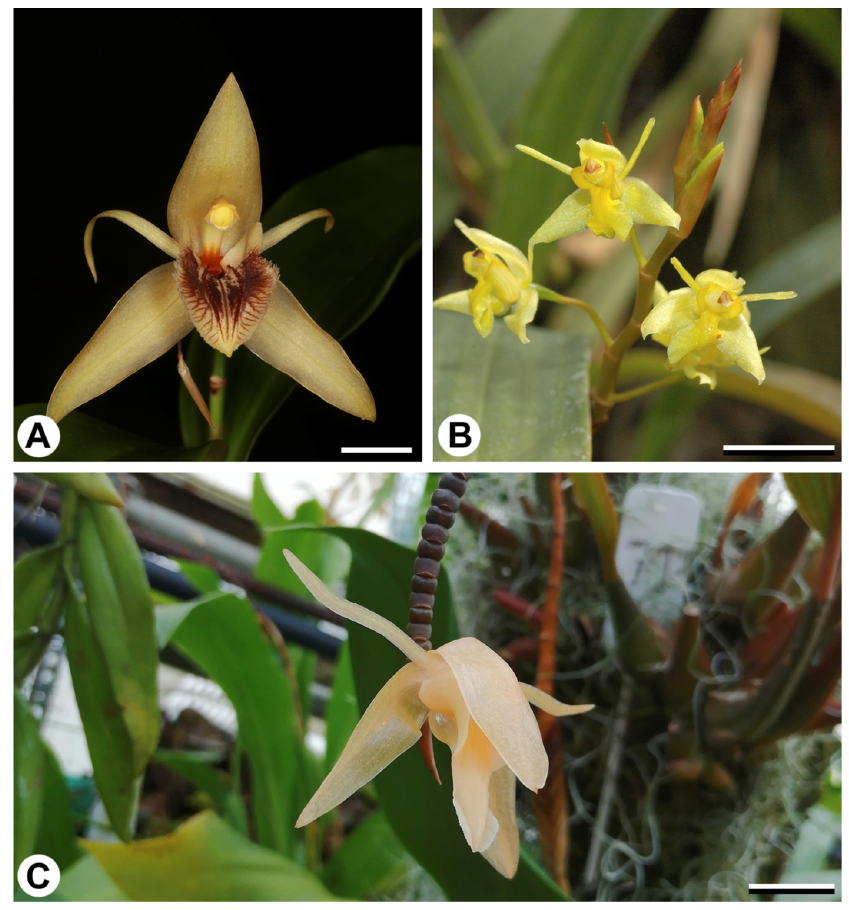
Figure 1. Flowers of Coelogyne species: ( A ) C. ovalis ; ( B ) C. prolifera ; ( C ) C. monilirachis . Scale bars: ( A , C ) = 1.5 cm; ( B ) = 1 cm.